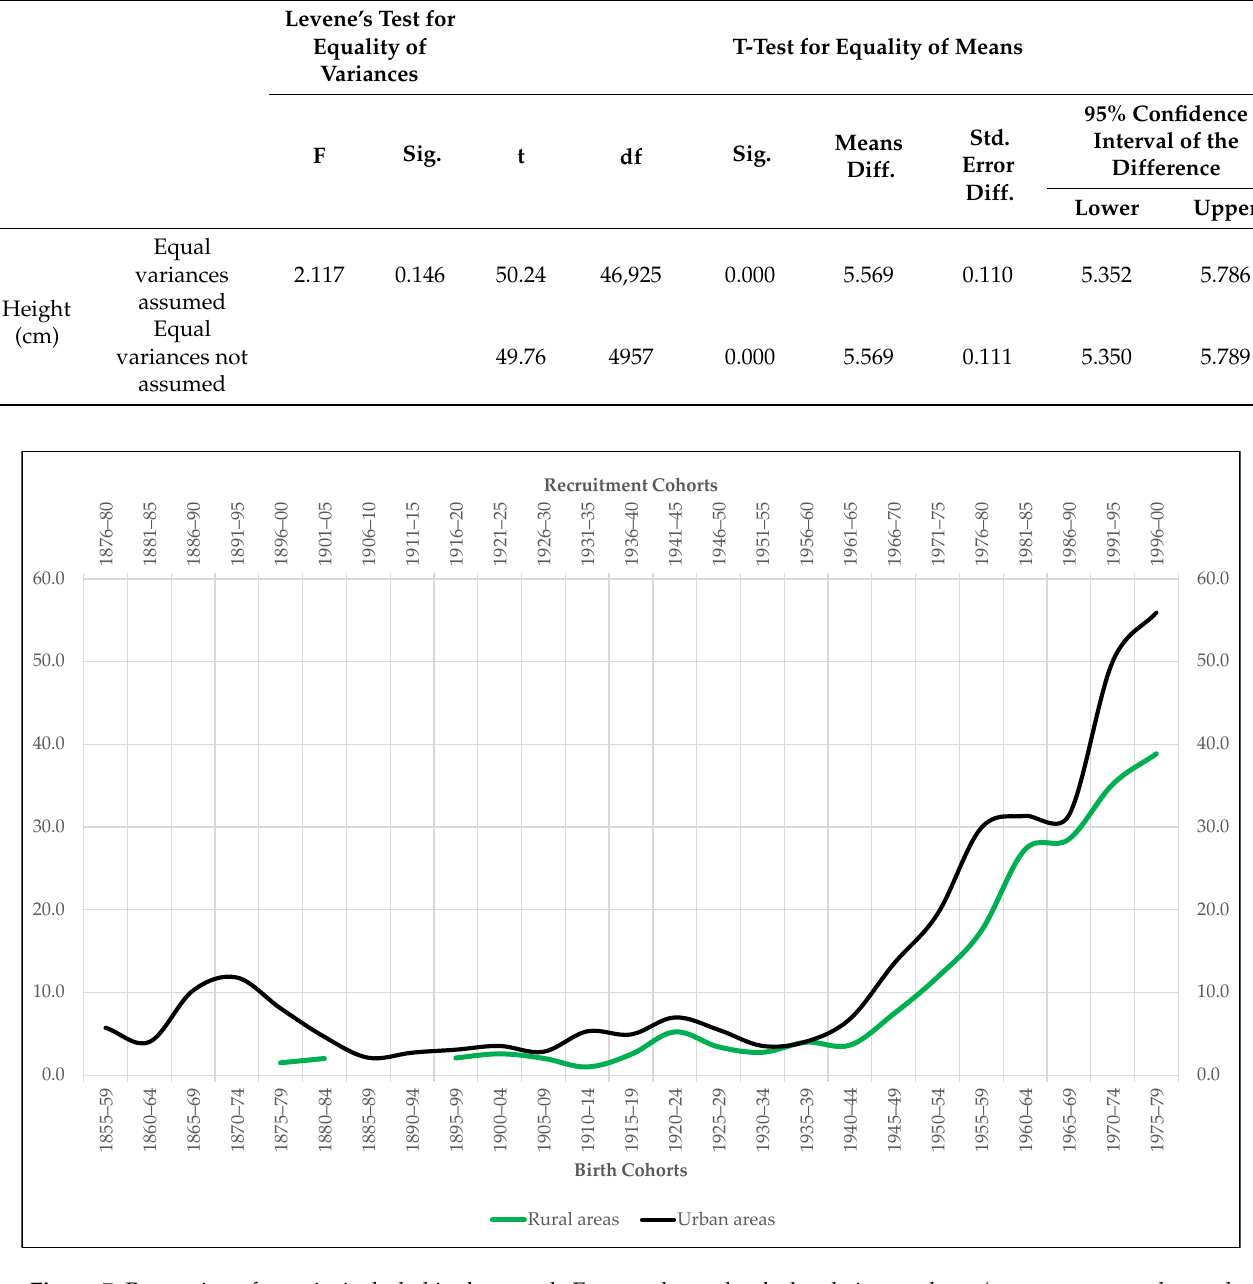
Figure 7. Proportion of recruits included in the sample Extremadura who declare being students (percentage over the total recruits who declare to exercise a profession).